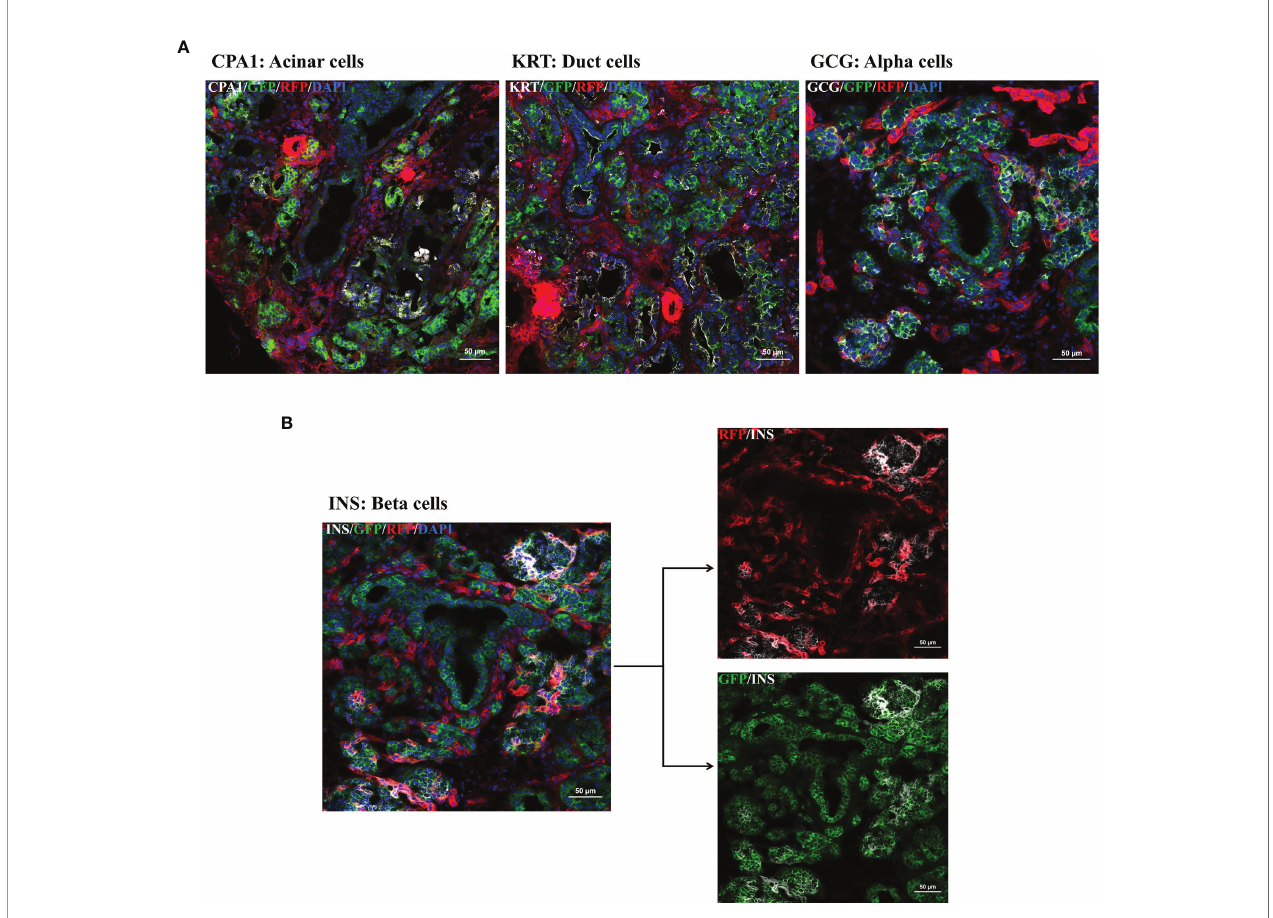
FIGURE 4 | Multi-color immuno fl uorescence staining for pancreatic cell type determination. IF staining for pancreatic progenitors was performed using frozen tissue samples of day 1 old R26 mT/mG / PTF1A 5 ’ iCre or PTF1A 3 ’ iCre piglets. (A, B) : Ductal cells, acinar cells, a -cells, and b -cells were stained using antibodies against cytokeratin, carboxypeptidase A, glucagon and insulin. (B) Co-staining of insulin with RFP and GFP. Scale bar represents 50